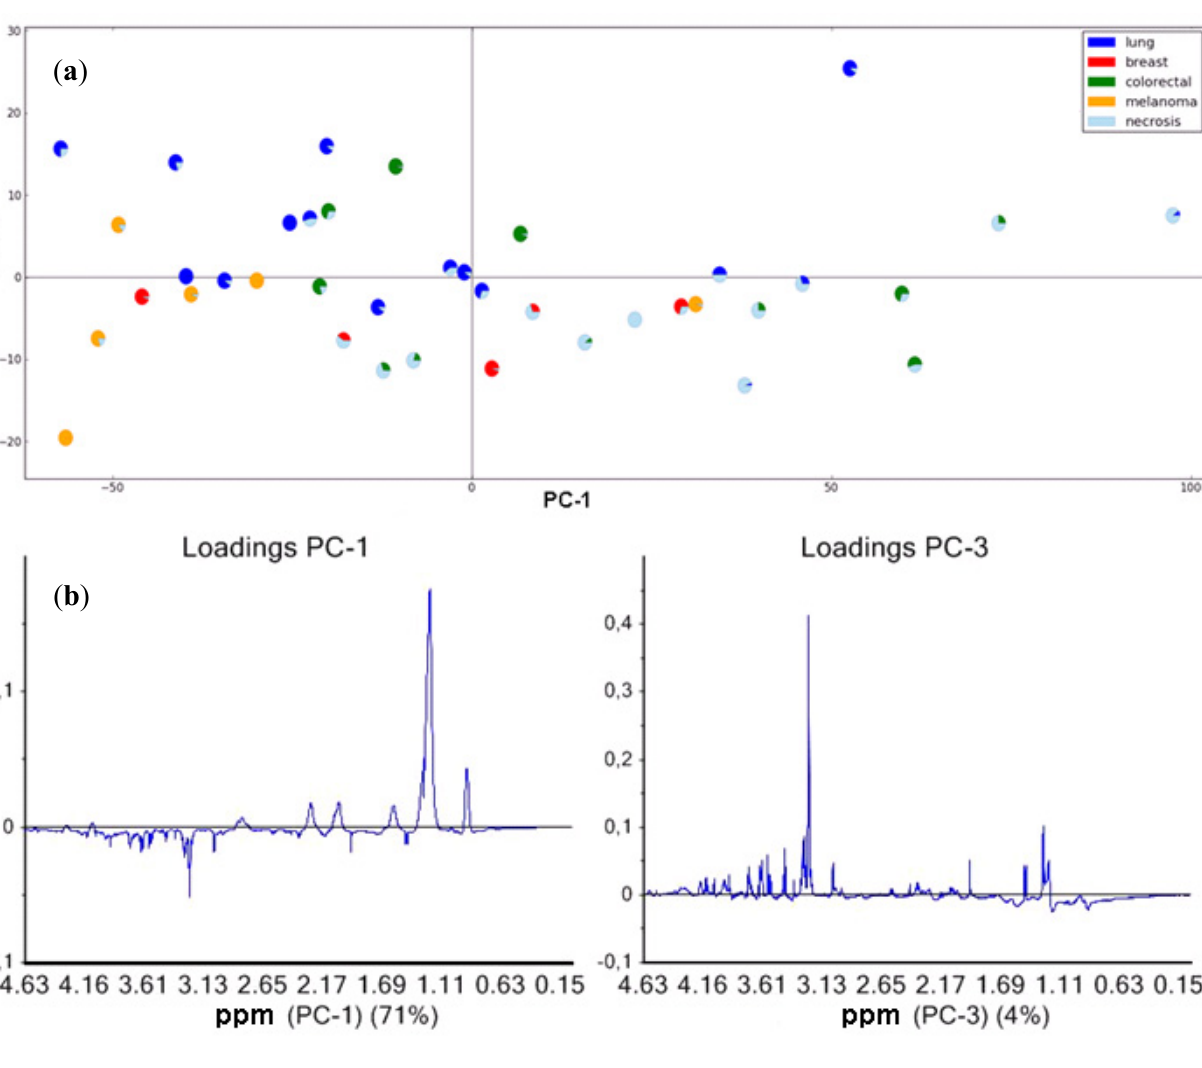
Figure 2. ( a ) Principal component analysis (PCA) score plot of PC-1 (explained variance 71%) and PC-3 (explained variance 4%) based on single-pulse spectra ( n = 39) showing the distribution of the metastases from four different primary cancer diagnoses; lung (blue), breast (red), colorectal (green) and melanoma carcinomas (yellow). The light blue colored part of the circles reflects the content of necrotic tissue determined by HES staining post HR-MAS; ( b ) Loading plots for PC-1 and PC-3; Samples with high score values for PC-1 have higher lipid levels. High score values for PC-3 are mainly due to high levels of phosphocholine